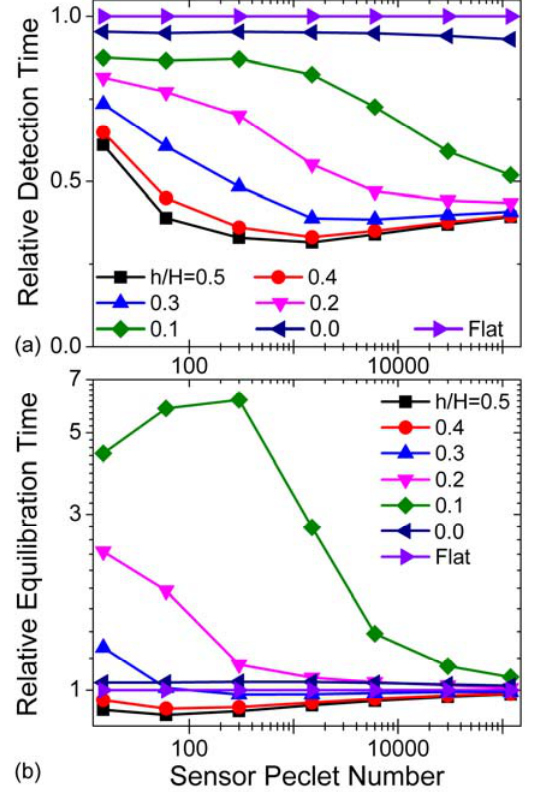
Figure 7. Response times as a function of sensor elevation/geometry and Sensor Péclet Number Pe (cid:3404) (cid:1874) (cid:1864) (cid:1830)⁄ (inlet bulk analyte concentration [A] (cid:3039) (cid:3036)(cid:3041) concentration of binding sites [B] = 1.66 × 10 − 8 mol/m 2 ). Note that in these simulations, m